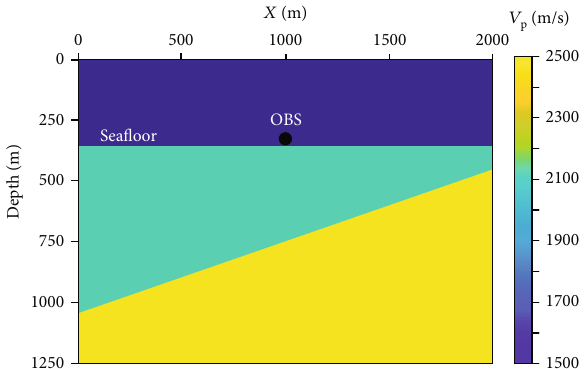
Figure 5: The velocity model for the numerical experiment. The velocity of the three layers is 1500m/s, 2000m/s, and 2500 m/s, respectively. The black dot indicates the OBS position on the sea fl oor. The sources lie on the sea surface with an interval of 5 m.